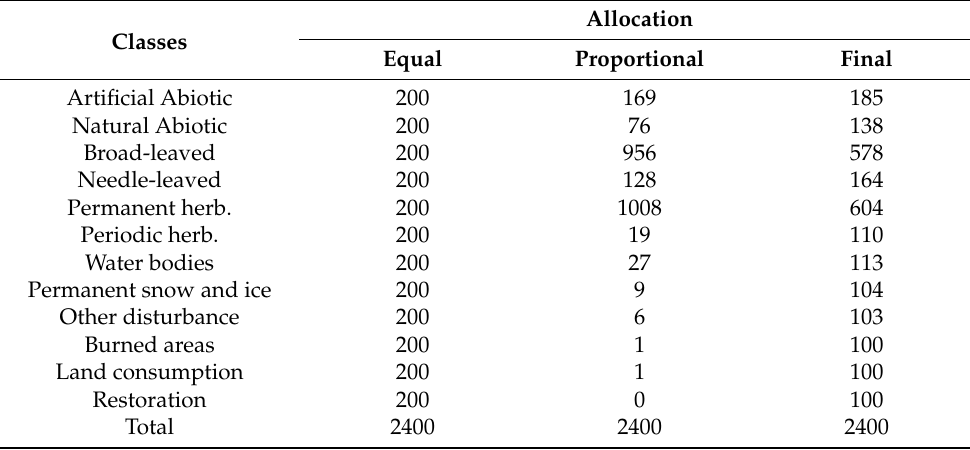
Table 6. Allocation of the sample between the considered classes.